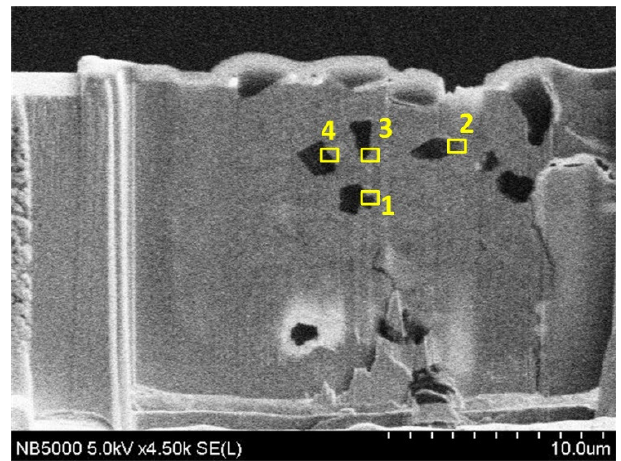
Figure 9. Cross section of specimen B after cutting by FIB and 1–4 representing different positions.